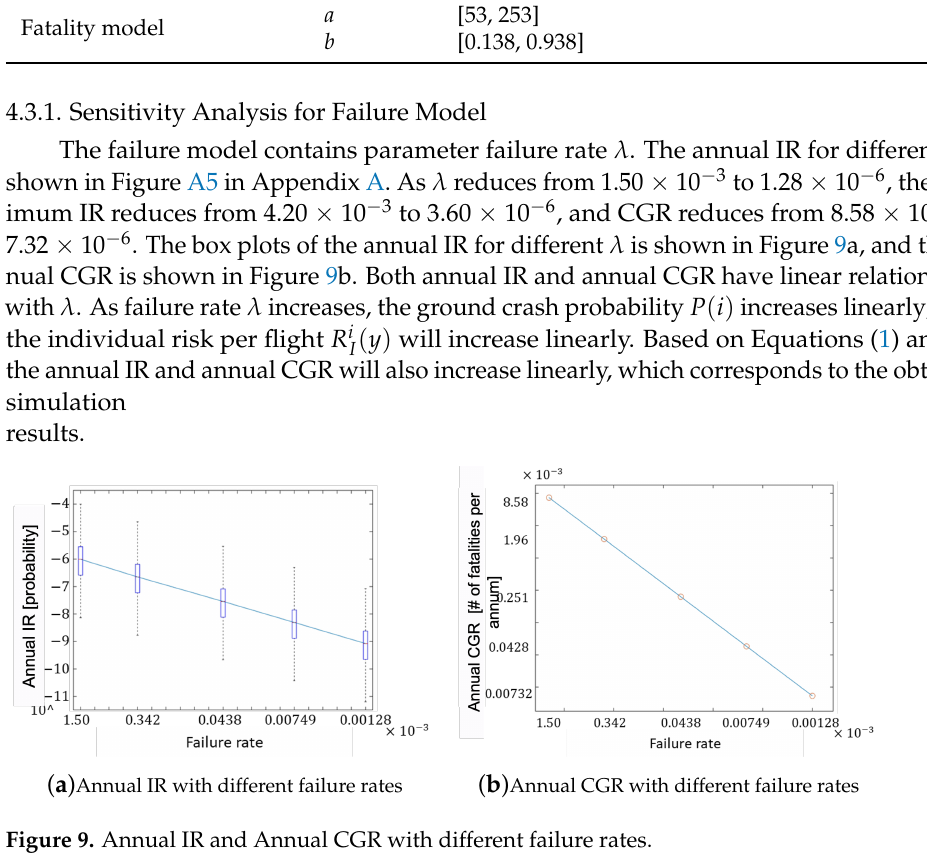
Figure 9. Annual IR and Annual CGR with different failure